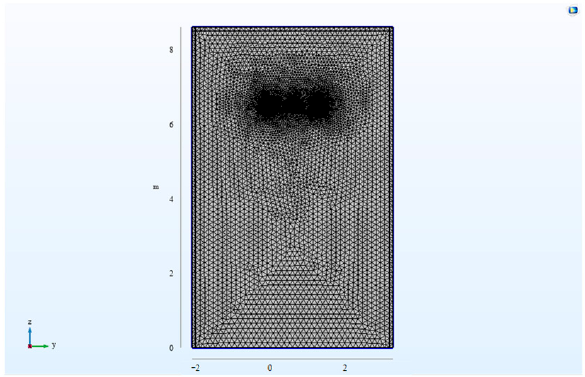
Figure 2. The cross-sectional view of the mesh division. The electric-field distribution of the plumb line below the three-phase conductor is calculated. The analysis of the electric field below the A-phase wire is taken as an example. When t = 0.05 s, the electric-field distribution of the plumb line below the A-phase wire is shown in Figure 3. Where the vertical coordinate E is the electric-field strength in the vertical ground direction, the horizontal coordinate h is the vertical height from the